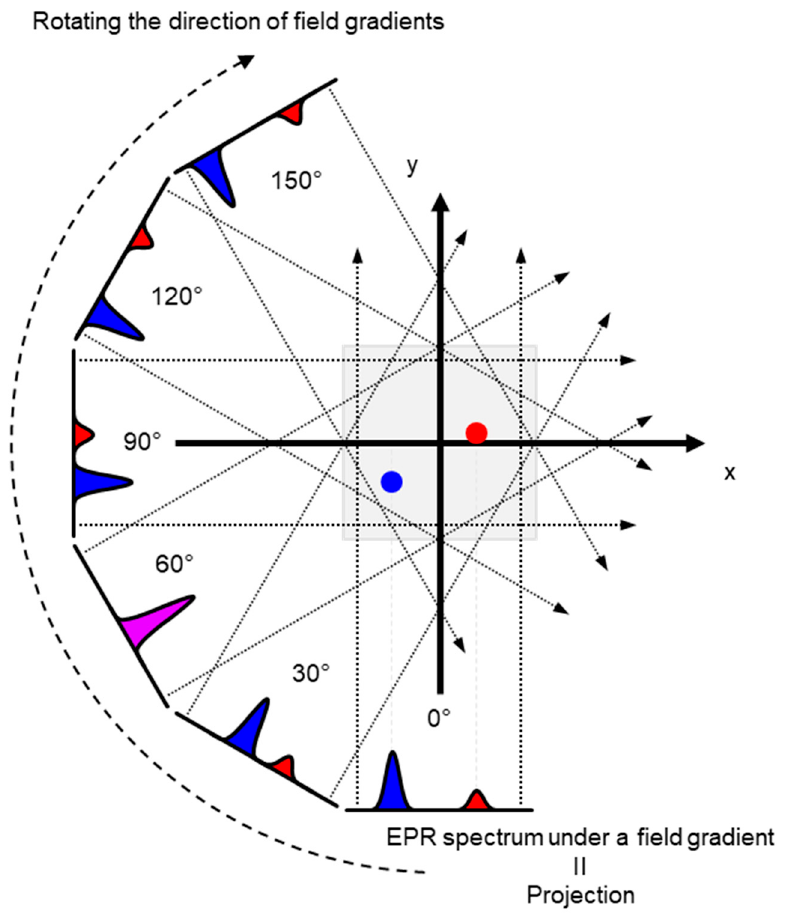
Figure 2. An example of 2D projection reconstruction imaging. Red and blue dots are 2D spatial positions of 2 objects. Rotating the direction of field gradient can provide different angle view of the subject, i.e., the projections. Projections are back-projected to 2D or 3D matrix, and the spatial distribution of subject can be reconstructed.